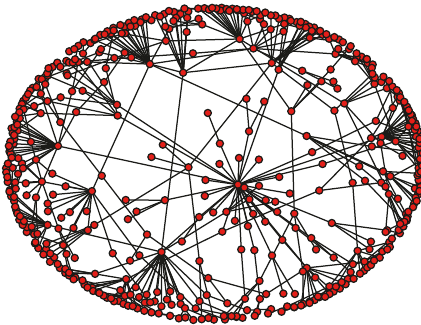
Figure 2: Scale-free network